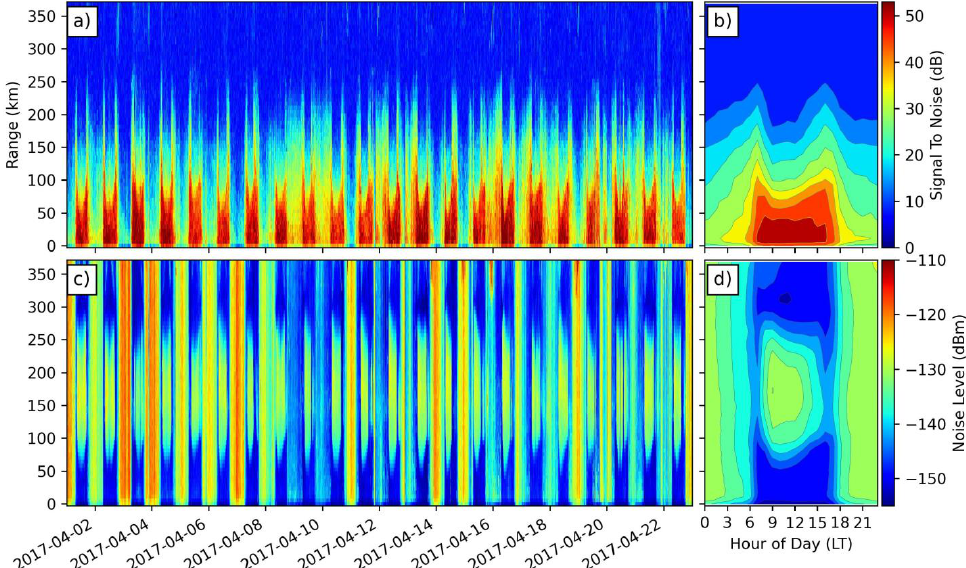
Figure 3. HFR backscatter spectra timeseries from ANGU between 1 April 2017 and 22 April 2017 for ( a ) SCNR and ( c ) C+NF, and the hour-of-the-day mean for ( b ) SCNR and ( d ) C+NF. SCNR and C+NF show diurnal variability, where hour-of-day mean of SCNR is at maximum values at dawn (07:00 LT) and dusk (17:00 LT) and a minimum around midnight (00:00 LT). Hour-of day-mean of C+NF show a nighttime feature that is characterized by high noise level at all ranges beginning after sunset (18:00 LT) and ending at sunrise (06:00 LT). This is followed by a daytime feature that is characterized by clutter originating around 90 to 100 km from the HFR and extending past 200 km range. The range to the feature decreases quickly to a minimum at 10:00 LT and increases gradually to another maximum preceding sunset. A “quiet” feature exists in between the daytime and nighttime features, typically at 07:00 LT and 16:00 LT.